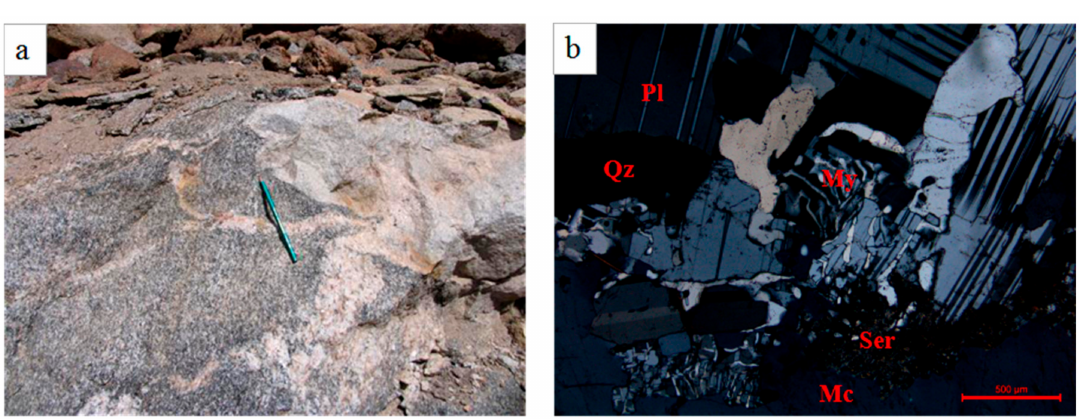
Figure 3. Field photograph and microphotograph for the biotite granite in the Gaudeanmus area, Namibia. ( a ) Alaskite intruding into biotite granite; ( b ) myrmekite develops at plagioclase and K-feldspar grain boundaries, crossed polarised light. Pl—plagioclase, Mc—microcline, My—myrmekite, Ser—sericite,